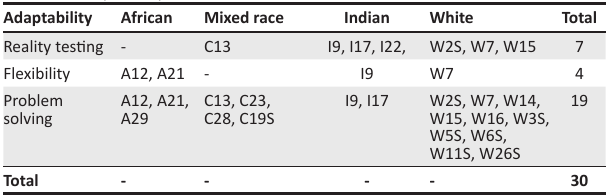
TABLE 4: Adaptability. Adaptability